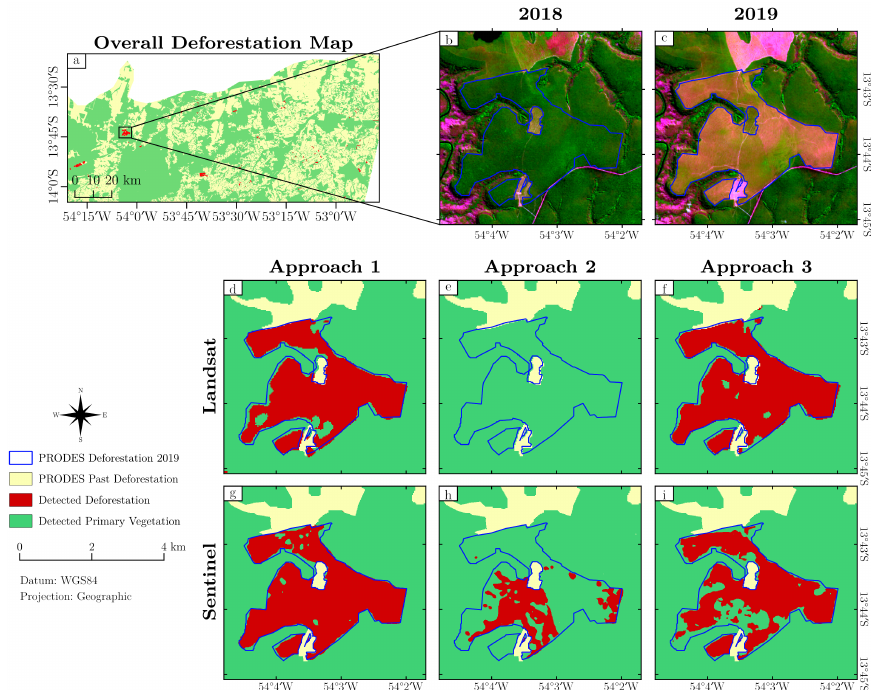
Figure 8. Results obtained for the largest deforestation polygon in the Mato Grosso study area. ( a ) PRODES Deforestation in 2019 in the study area in Mato Grosso. ( b , c ) RGB (Band 11, Band 8, Band 4) Sentinel-2/MSI images in 4 July 2018 and 4 July 2019, respectively, overlaid on the largest PRODES deforestation polygon for Mato Grosso study area in 2019; ( d , e , f ) Deforestation maps using Landsat-8/OLI time series and Approaches 1, 2, and 3, respectively; ( g , h , i ) Deforestation maps using Sentinel-2/MSI time series and Approaches 1, 2, and 3,